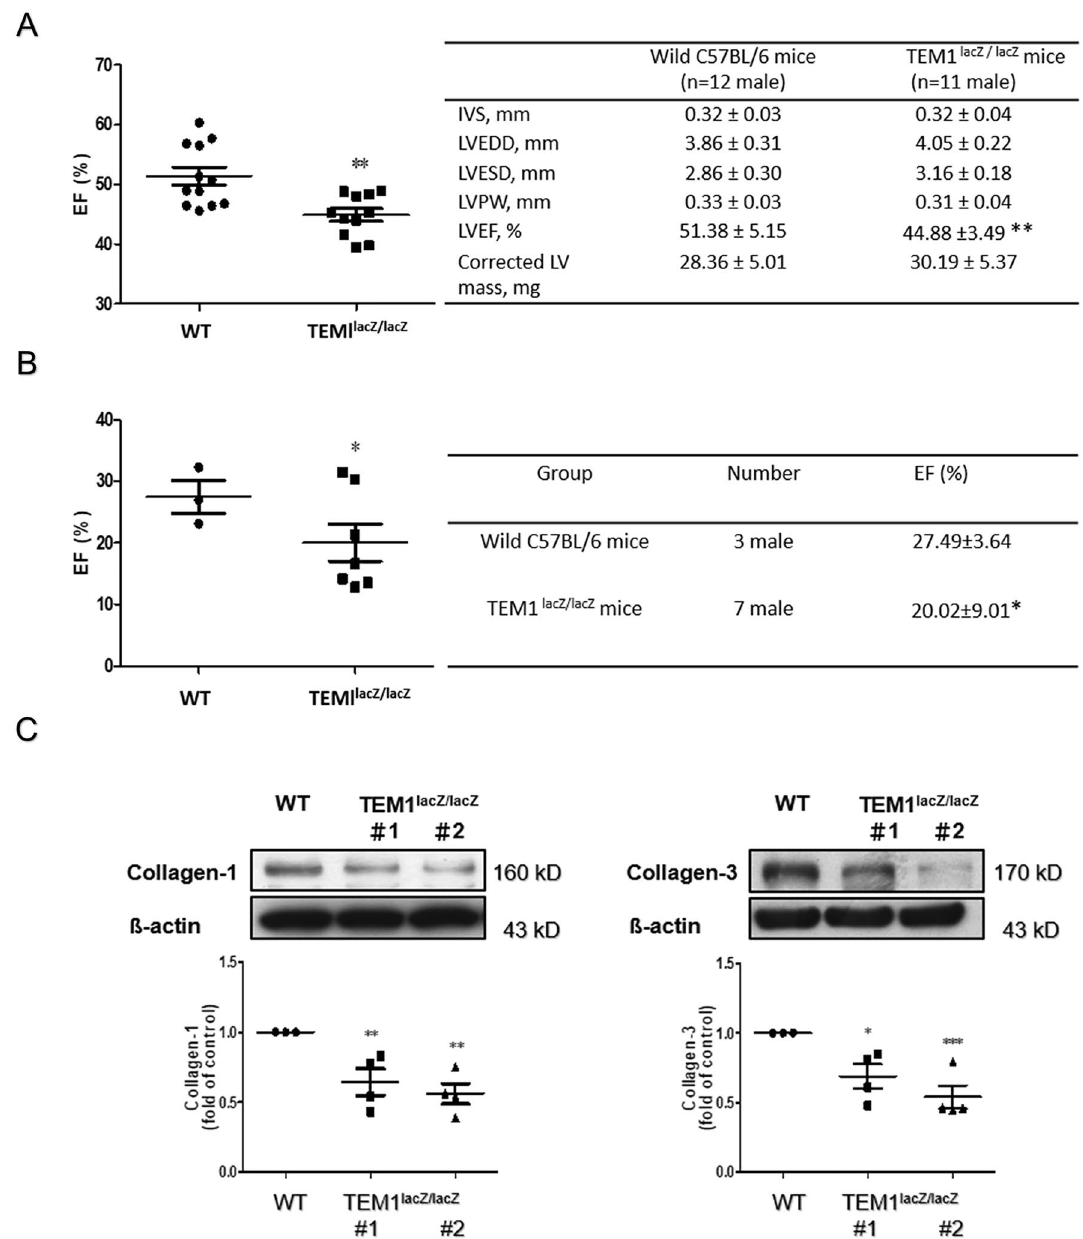
Figure 5. Cardiac contractility and collagen content of TEM1 LacZ/LacZ mice. ( A ) Cardiac contractility evaluated by echocardiography. *p < 0.05 compared to wild type mice. IVS, interventricular septum; LVEDD, left ventricular end-diastolic dimension; LVESD, left ventricular end-systolic dimension; LVPW, left ventricular posterior wall; LVEF, left ventricular ejection fraction. ( B ) Cardiac contractility evaluated by pressure volume loop analysis. **p < 0.01 compared to wild type mice. ( C ) Collagen expression levels in 2 hearts of TEM1 LacZ/LacZ mice (#1 and #2) were analyzed by western blot (n = 4). *p < 0.05 compared to wild type mice. Original images of western blot were provided in “Supplemental